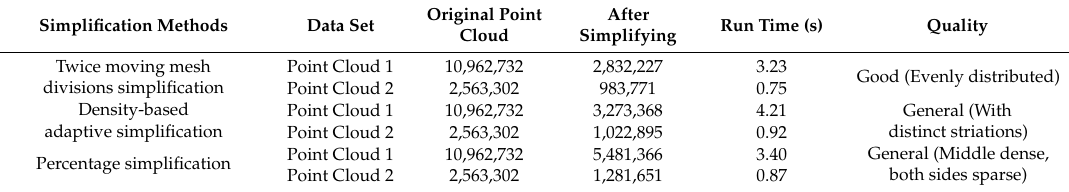
Table 1. Comparison of simplification results of multiple